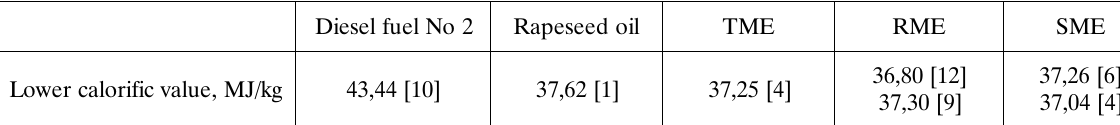
Table 3. Calorific values of fuel